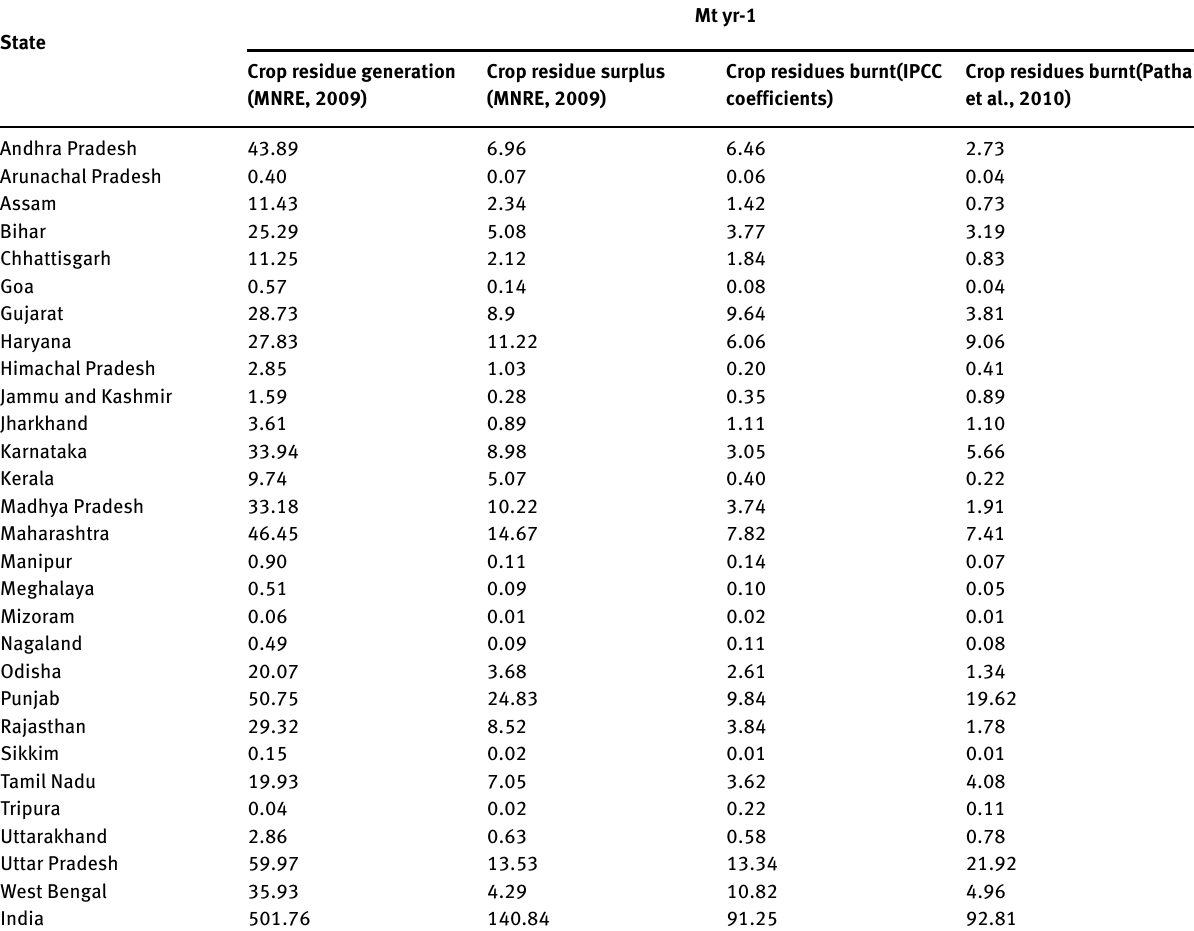
Table 5: State-wise generation and remaining surplus of crop residues in India State